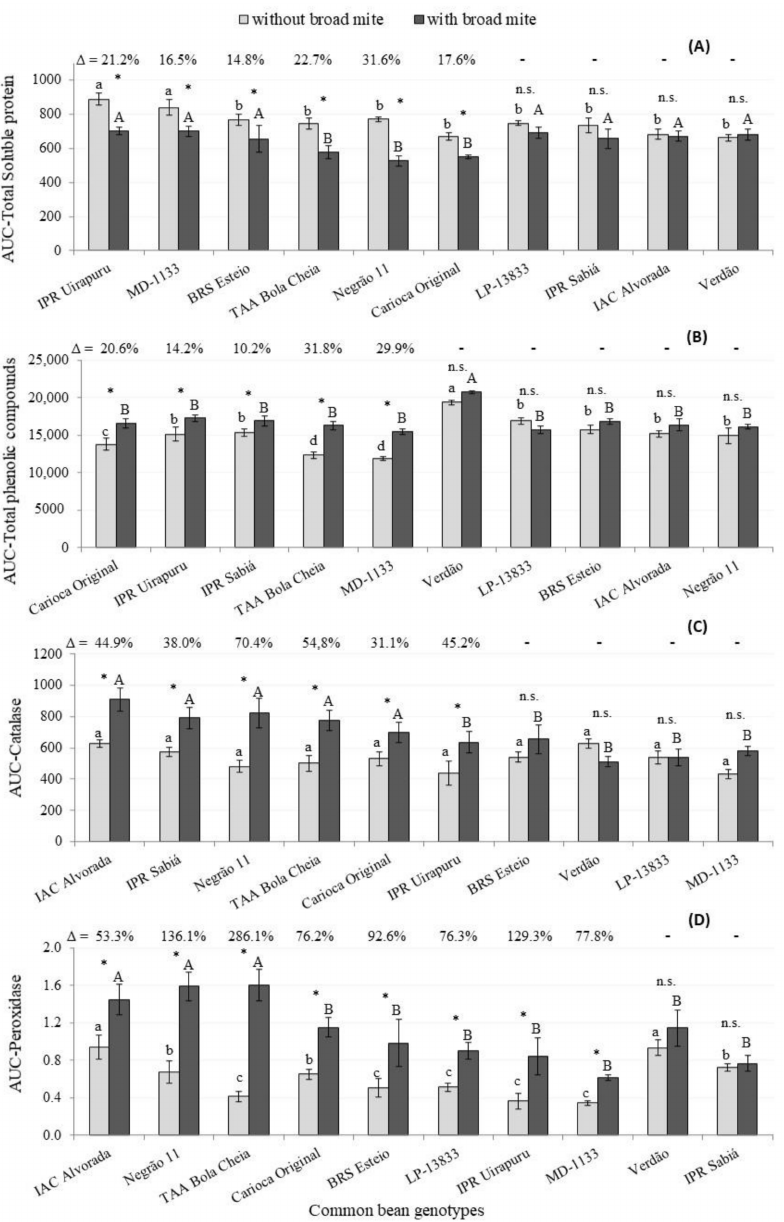
Figure 6. Areas under the curve total soluble proteins ( A ), total phenolics ( B ), catalase ( C ) and peroxidase ( D ) contents in leaves from different common bean genotypes infested (dark column) and not infested (clear column) with Polyphagotarsonemus latus . Values obtained from assessments one day before and 1, 2, 6, 8, 10, 13 and 15 days after P. latus infestation. Columns with the same letter, lower case (a, b, c) for “without broad mite” and capital letters (A, B) for “with broad mite”, do not differ by Scott–Knott test ( α = 5%). Asterisks over bars indicate significant difference by Student’s t test ( p < 0.05) and n.s. indicates not significant. ∆ values indicate the increment when infested vs. non-infested plants were